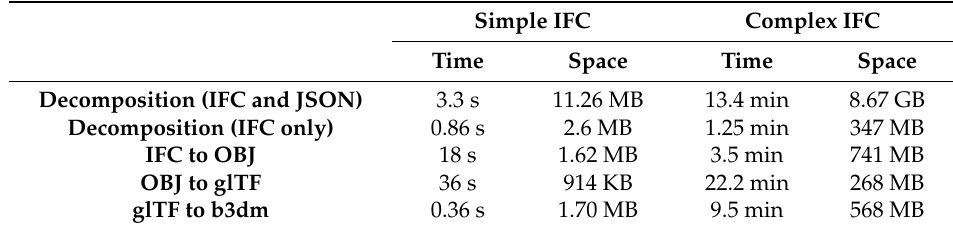
Table 1. IFC to 3D Tiles conversion processing time and intermediate disk usage for a simple (3.03 MB) and a complex (214 MB)